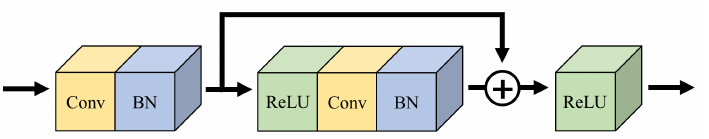
Figure 3. The architecture of up-sampling nested connection.